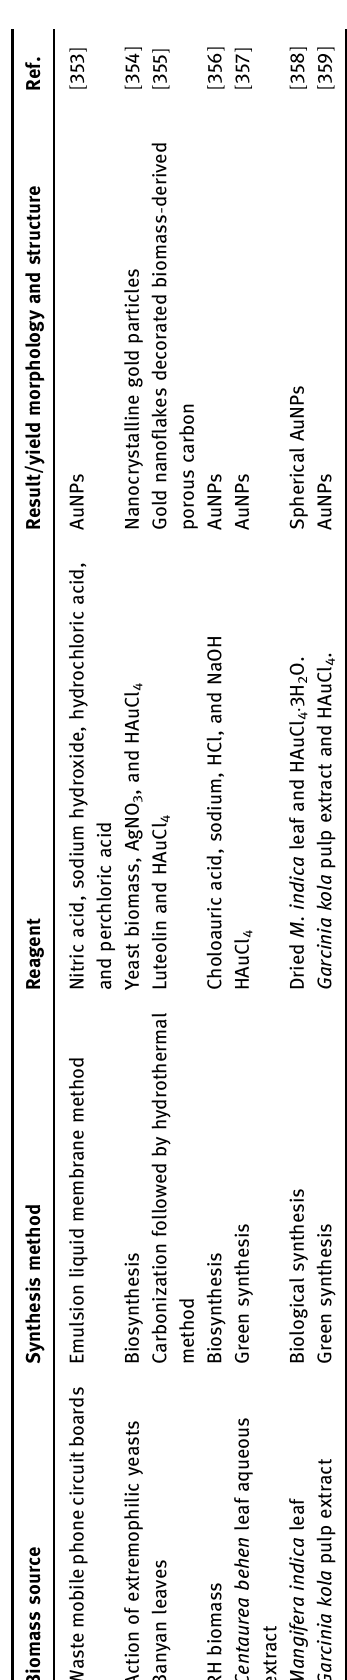
Figure 28. Also, Table 4 shows the synthesis of AuNPs derived from di ff erent waste sources.